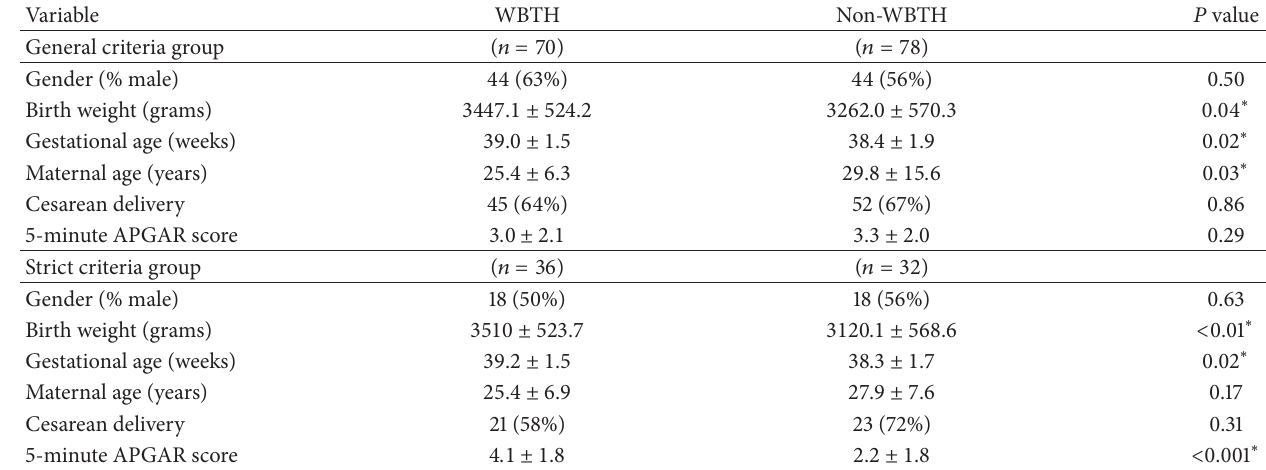
Table 1: Demographics for all